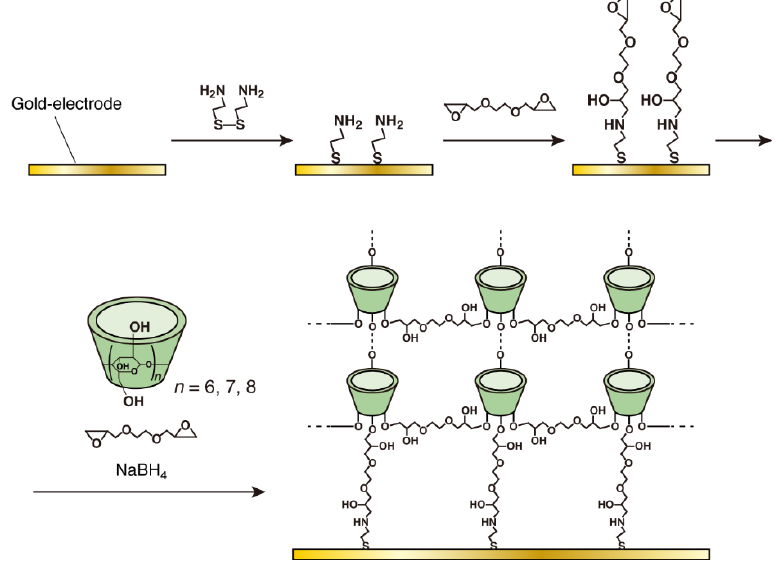
Figure 2. Schematic illustration of the process for preparing a CD film networked with ethylene glycol diglycidyl ether (EGDE) on a sensor surface.